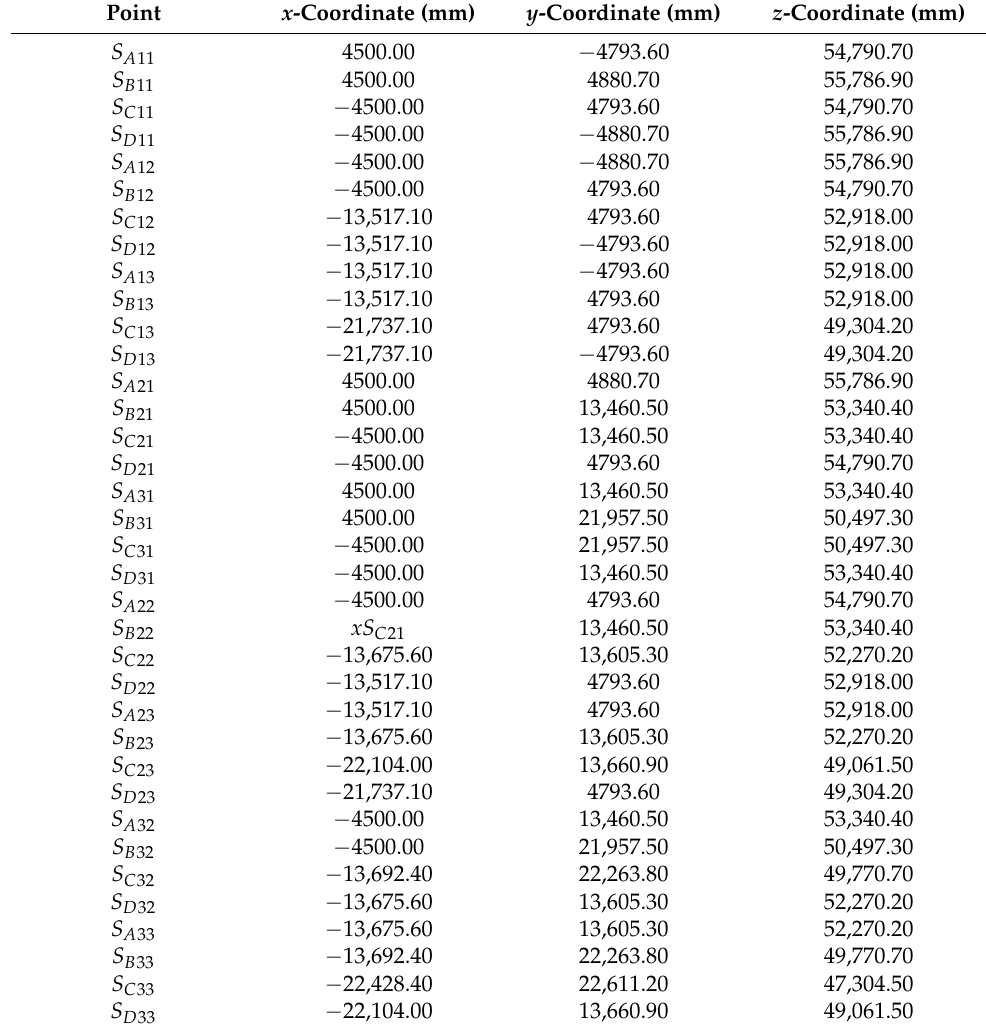
Table A2. The coordinates of the points S Aij , S Bij , S Cij , S Dij (for i, j = 1, 2, 3) of the reference surface network ω r